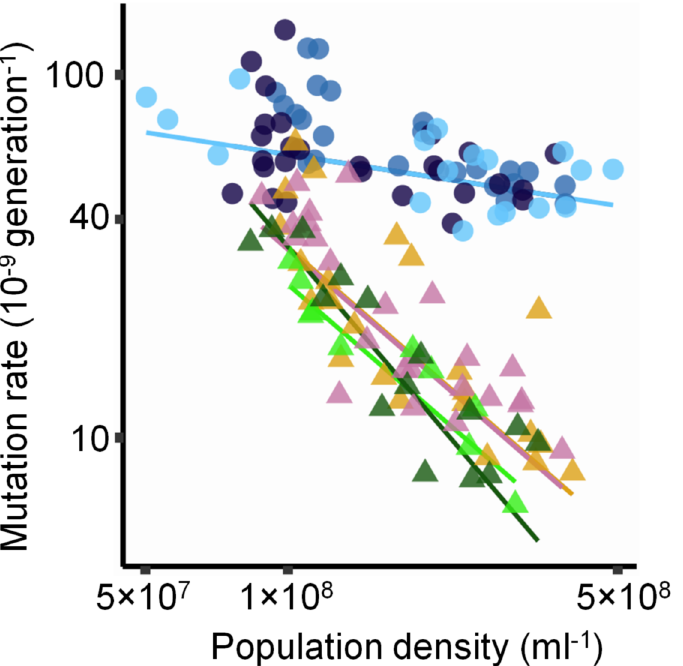
Fig 3. Density-associated mutation-rate plasticity (DAMP) in strains of E . coli with deficiencies in various DNA repair and other systems. Mutation rate in strains from the Keio collection[24] deletedfor genesencodingdeoxyadenosine methylase ( Δ dam , N = 23, yellow triangles), error-proneDNA polymerase Pol IV ( Δ dinB , N = 25, pink triangles), methionine transporter MetI ( Δ metI , N = 10, light green triangles), endonuclease VIII ( Δ nei , N = 15, dark green triangles), and each protein of methyl-directed DNA mismatch repair (MMR), which comprisesMutS ( Δ mutS , N = 28, light blue circles) that binds mismatched DNA and MutL ( Δ mutL , N = 27, dark blue circles) that interacts with MutS to activate endonuclease MutH ( Δ mutH , N = 24, medium blue circles). All lines result from Model S-VII in S1 Text. Wald tests that averageslope for Δ dam , Δ dinB ,and Δ metI is 0: t 92 = 17; P = 4.2 × 10 − 30 , that averageslope for Δ nei is 0: t 91 = 13; P = 6.0 × 10 − 22 , and that averageslope for MMR strains is 0: t 91 = 4.3; P = 5.1 × 10 − 5 . See S2 Table for further strain details. Densitiesestimated by ATP-based luminescenceassay. As in Fig 2, trianglesand circles indicatemutation rates to rifampicin and nalidixicacid resistance, respectively.Note the logarithmic axes. Raw data are available in S1 Data. S-VIII in S1 Text). MutT is the mutation-avoidance component of the 8-Hydroxyguanine (GO) system, protecting cells from mutagenic effects of damaged nucleotides [23]. Specifically,